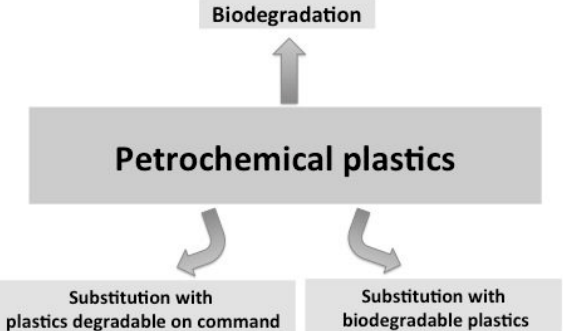
Figure 2. Possible strategies to counteract petrochemical plastics pollution.